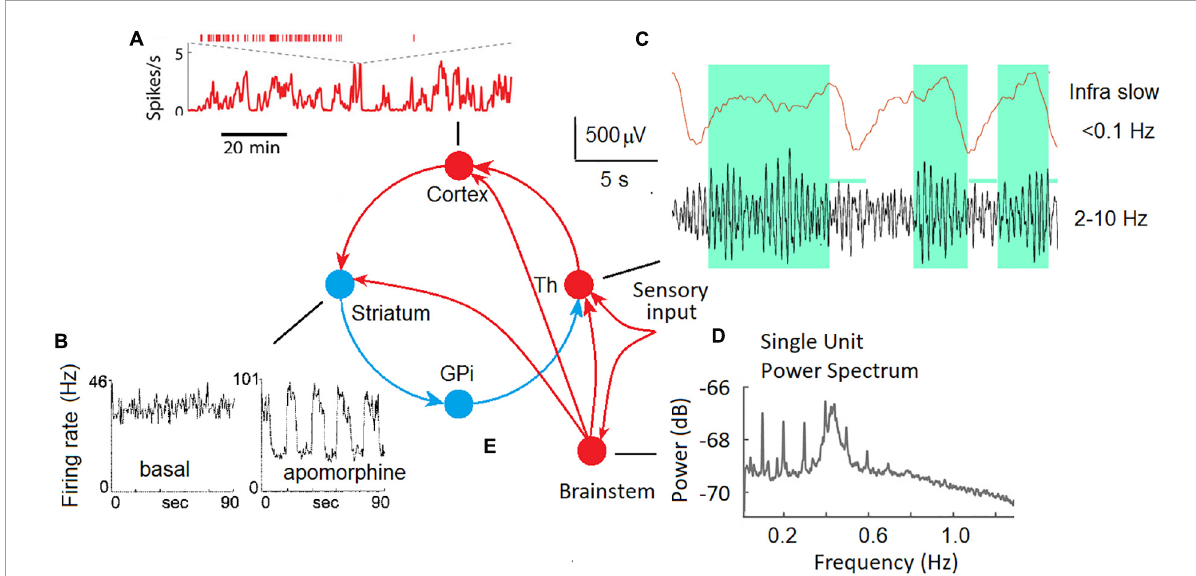
FIGURE1 ISF in neuronal activity of different brain areas in animal experiments. (A) Fast and slow timescale dynamics of a cortical neuron in the mouse medial prefrontal cortex (Okun et al., 2019). (B) The spike trains for a representative neuron in the globus pallidus recorded in an awake rat in the background (basal), and in response to a dopamine agonist (apomorphine) (Ruskin et al., 1999). (C) Local field potentials in the lateral geniculate body of the thalamus of a freely moving cat; upper trace – ISF, bottom trace – conventional EEG filtered at 2–10 Hz, note that periods of increased alpha activity are associated with positive-going deflections in infra slow fluctuations (Hughes et al., 2011). (D) The plot shows the power spectrum averaged across all single units. Two oscillatory regimes at 0.1 Hz and between 0.4 and 0.5 Hz were observed in single-unit spike trains (Totah et al., 2018). (E) Cortical-basal ganglia-thalamocortical loop with excitatory (red) and inhibitory (blue) pathways (Alexander et al., 1990) and the thalamic sensory